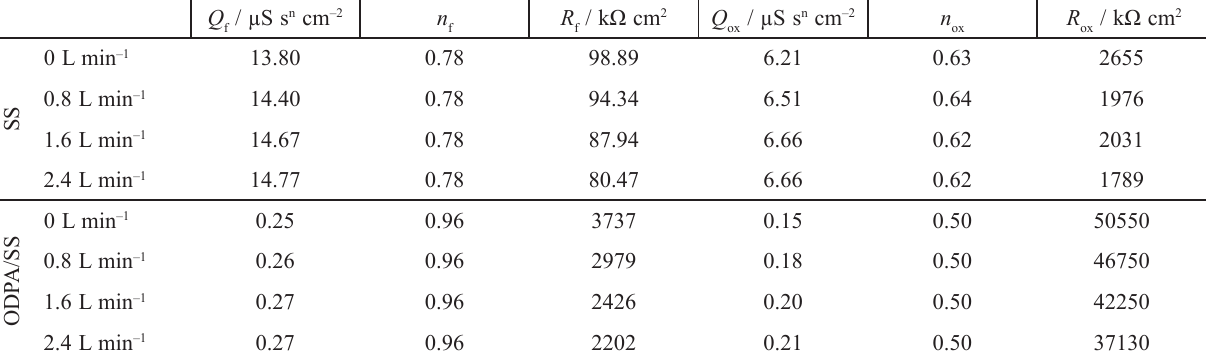
10 – Nyquist plots of EIS spectra for blank and ODPA-treated stainless steel in different seawater flow rates. Dots represent experimental data, and lines represent the fitted data obtained by fitting the spectra to models given in Fig. Table 3 – Impedance parameters obtained for SS in river water